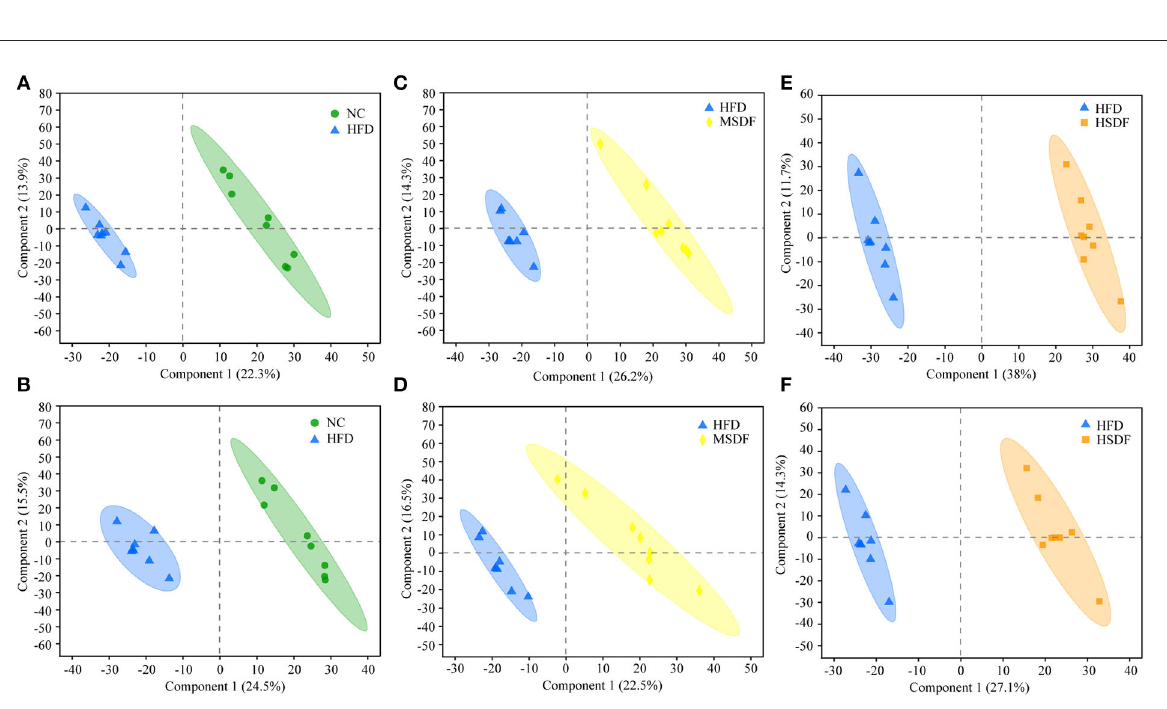
FIGURE4 PLS-DA score plots. (A) PLS-DA model plot for the comparison group HFD vs. NC, positive ion mode, R 2 X = 0.362, R 2 Y = 0.995, Q 2 = 0.934; (B) PLS-DA model plot for the comparison group HFD vs. NC, negative ion mode, R 2 X = 0.472, R 2 Y = 0.998, Q 2 = 0.922; (C) PLS-DA model plot for the comparison group MSDF vs. HFD, positive ion mode, R 2 X = 0.405, R 2 Y = 0.991, Q 2 = 0.943; (D) PLS-DA model plot for the comparison group MSDF vs. HFD, negative ion mode, R 2 X = 0.541, R 2 Y = 0.993, Q 2 = 0.913; (E) PLS-DA model plot for the comparison group HSDF vs.